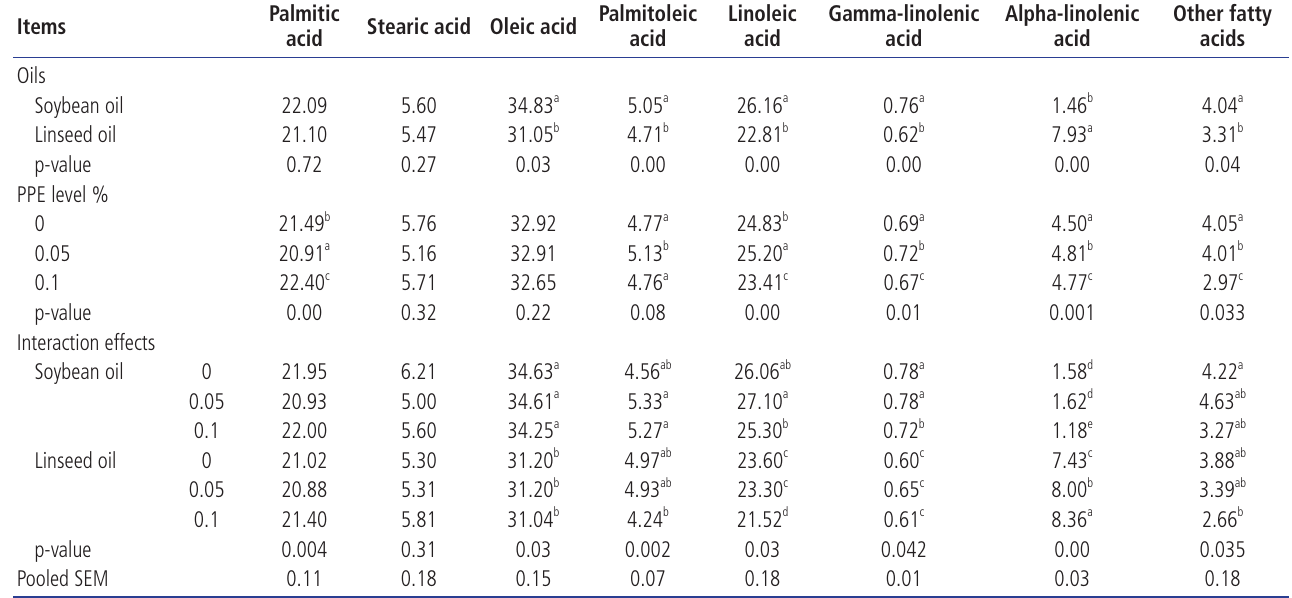
Table 8. Effects of different dietary levels of pomegranate peel extract with different oil sources and their interactions on broiler breast muscle fatty acid profile (% of total fatty